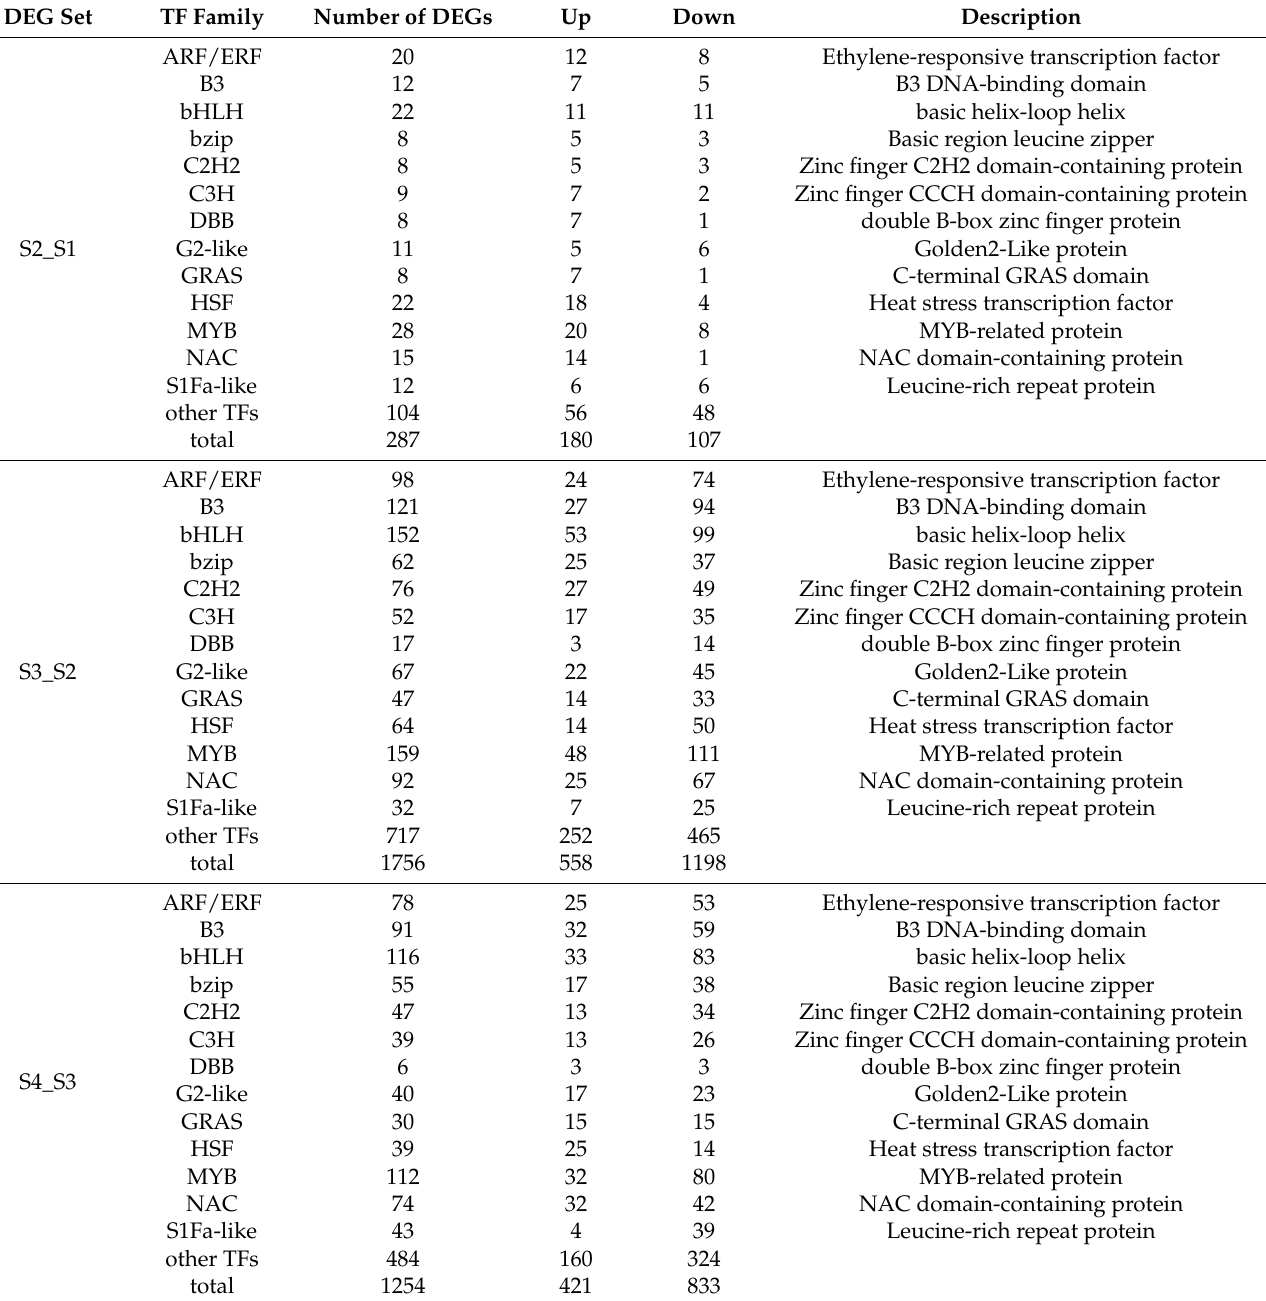
Table 1. Differentially expressed transcription factors (TFs) in fruit